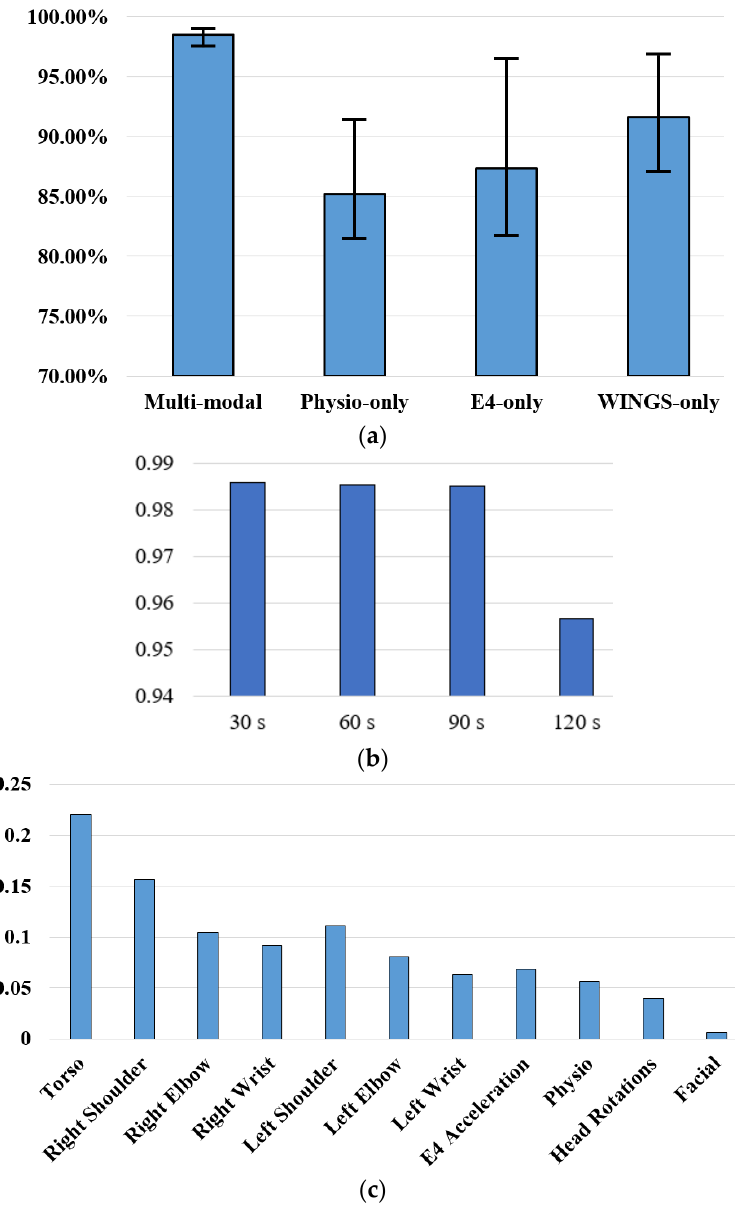
Figure 9. ( a ) Prediction Accuracies of Different Data Modality Models; ( b ) Interval Analysis; and ( c ) Feature Importance